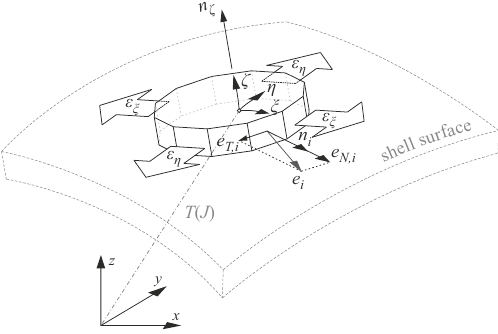
Figure 7. Microplane model within a single layer of a shell cross